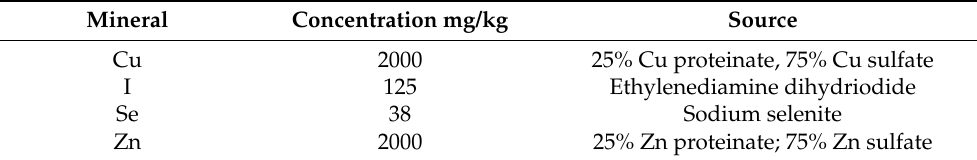
Table 2. Trace mineral concentrations of free-choice supplement 1 provided during the study 2 .